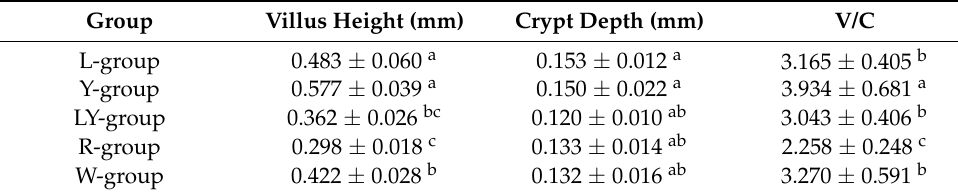
Table 2. The villus height (mm), crypt depth (mm) and the ratio of villus height to crypt depth (V/C) of mice’s intestinal histology in different experimental groups (L-group, Y-group, LY-group, R-group and W-group).